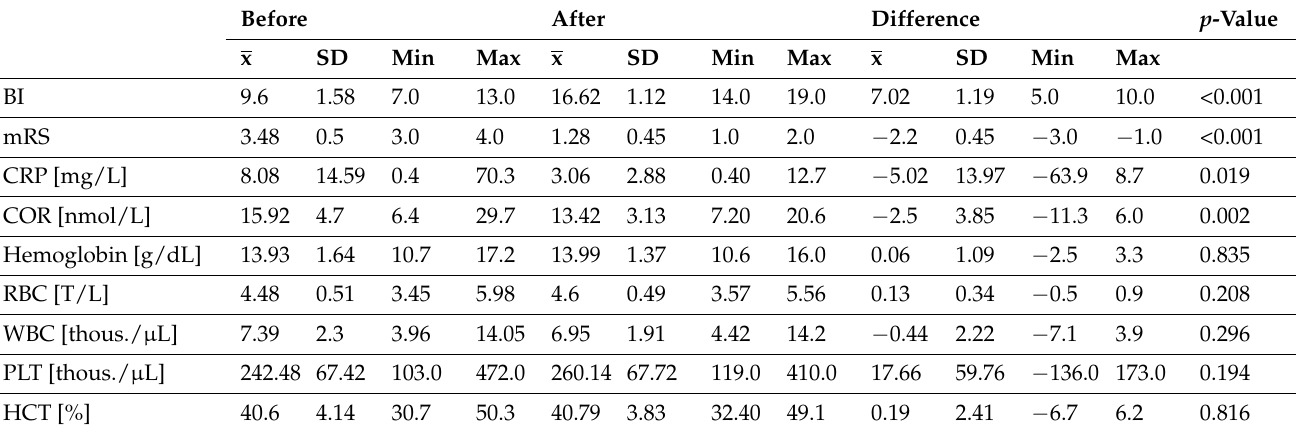
Table 3. Comparisons of results before and after rehabilitation.